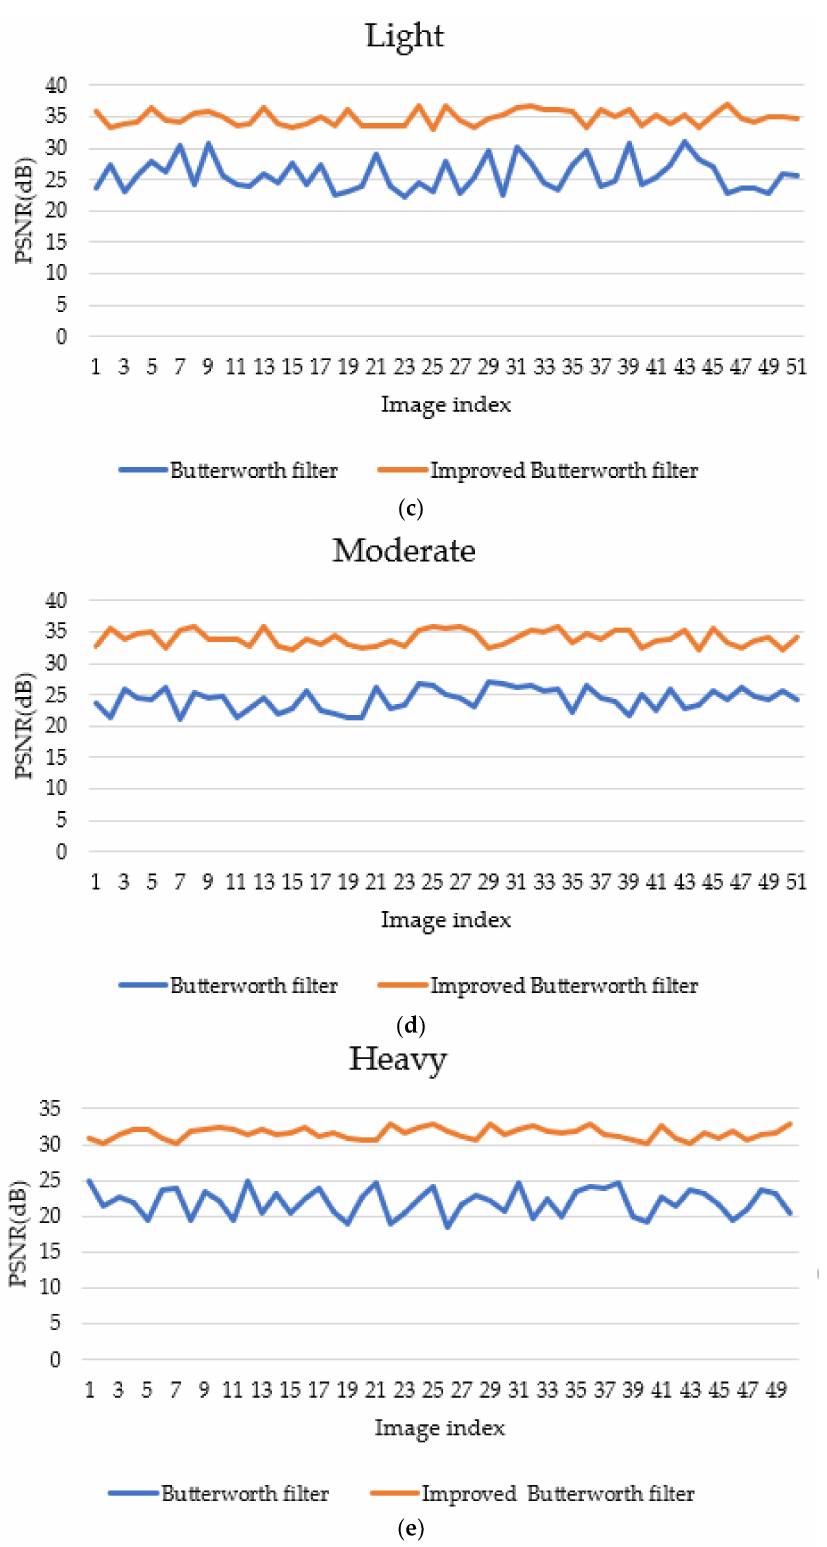
Figure 20. PSNR comparison of original Butterworth filter with improved Butterworth filter. ( a ) is the PSNR comparison when level is excellent; ( b ) is the PSNR comparison when level is good; ( c ) is the PSNR comparison when level is light; ( d ) is the PSNR comparison when level is moderate; ( e ) is the PSNR comparison when level is